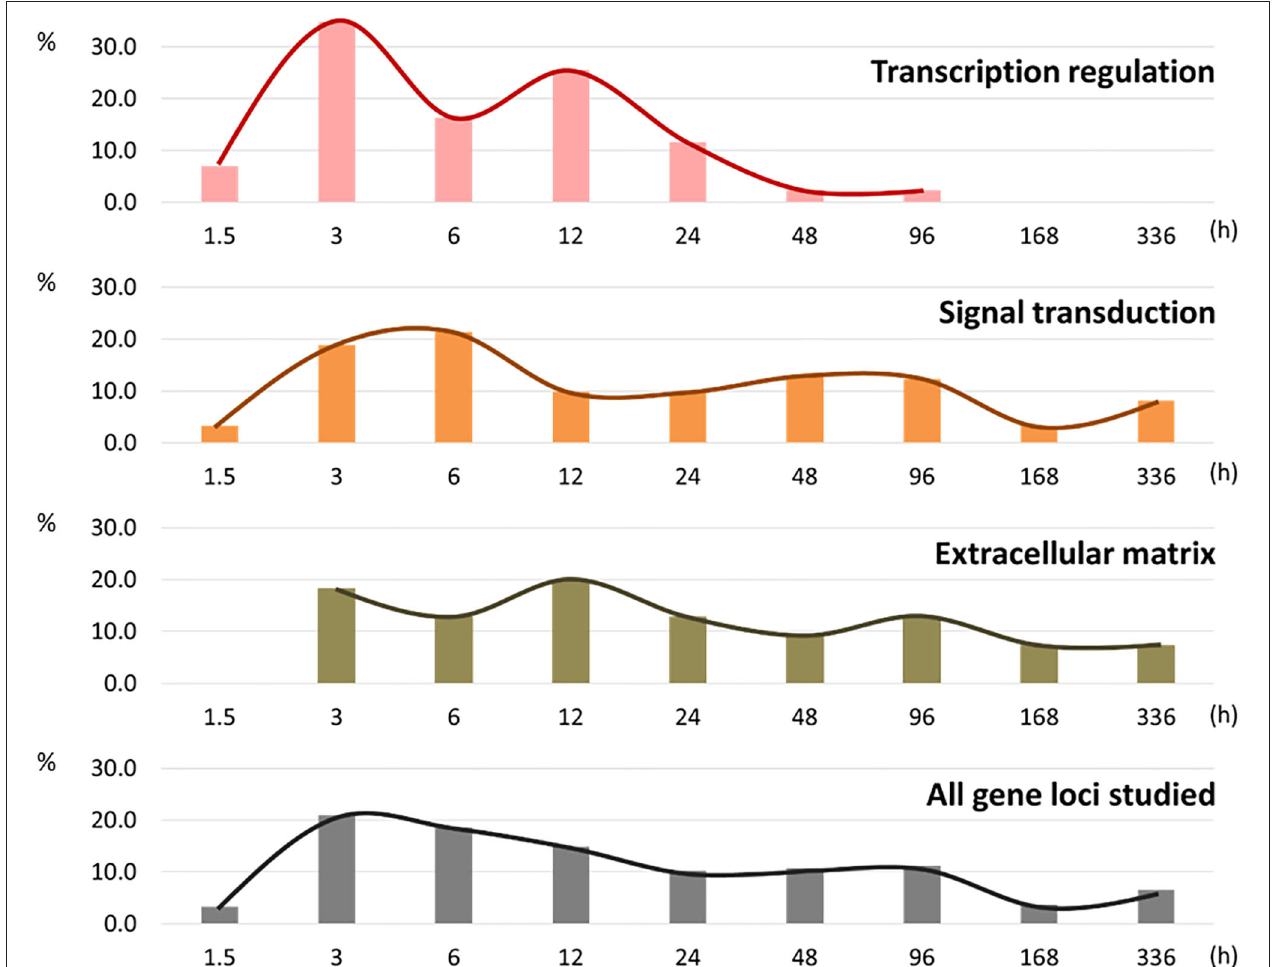
FIGURE 2 | Histogram of percentages of the first response to the chondrogenic stimulation in new gene × cell type combinations within each of the three functional annotation groups.